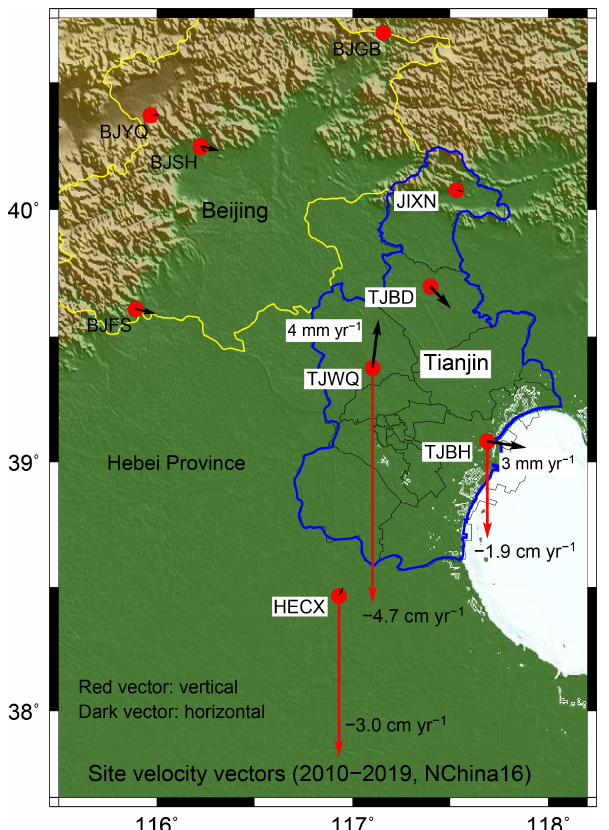
Figure 2. Vertical (red) and horizontal (dark) site velocity vectors (NChina16) derived from 10-year GPS (2010–2019) observations at nine locations in Tianjin and its surrounding